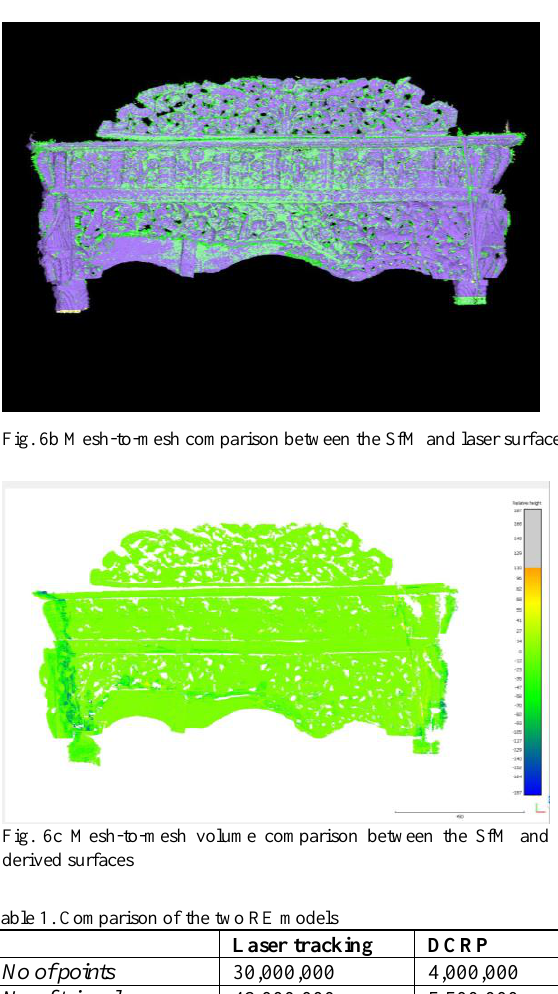
Fig. 6a Point-to-point comparison between the SfM and laser clouds